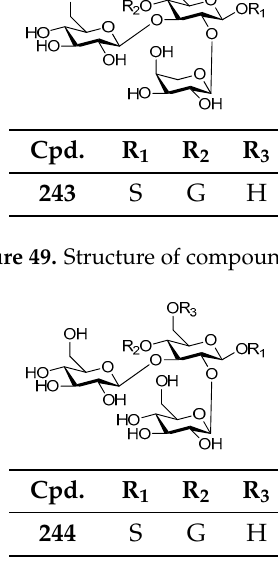
Figure 48. Structures of compounds 241 – 242 .